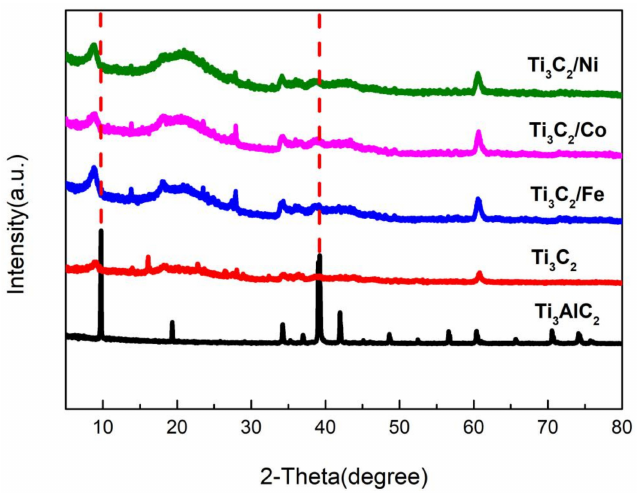
Figure 4. XRD patterns of Ti 3 AlC 2 , Ti 3 C 2 , and Ti 3 C 2 /Fe 3+ /Co 2+ /Ni 2+